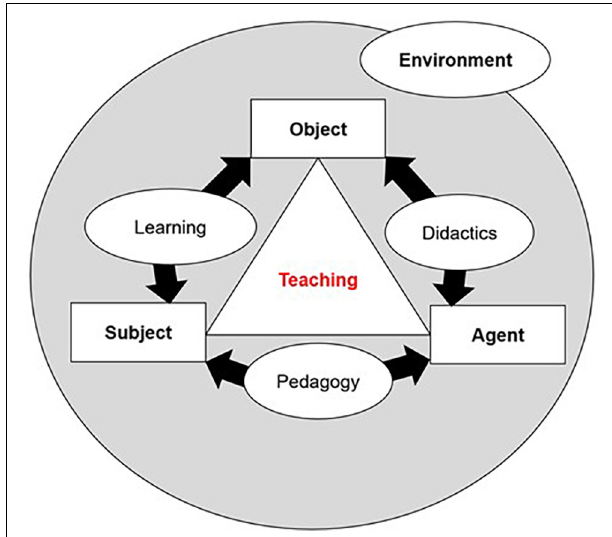
FIGURE 2 | SOEA model (Legendre,